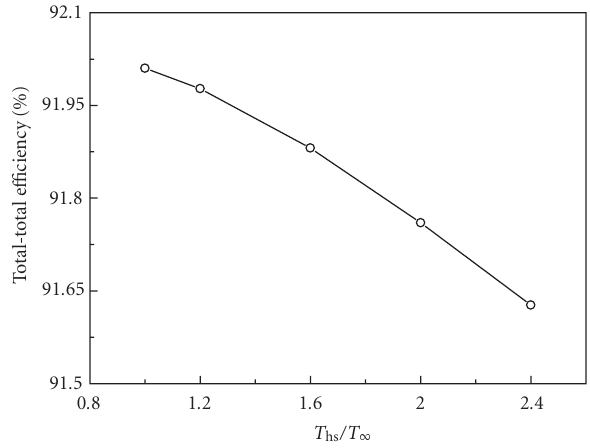
Figure 15: The influence of hot streak temperature ratio on the total-total e ffi ciency of the